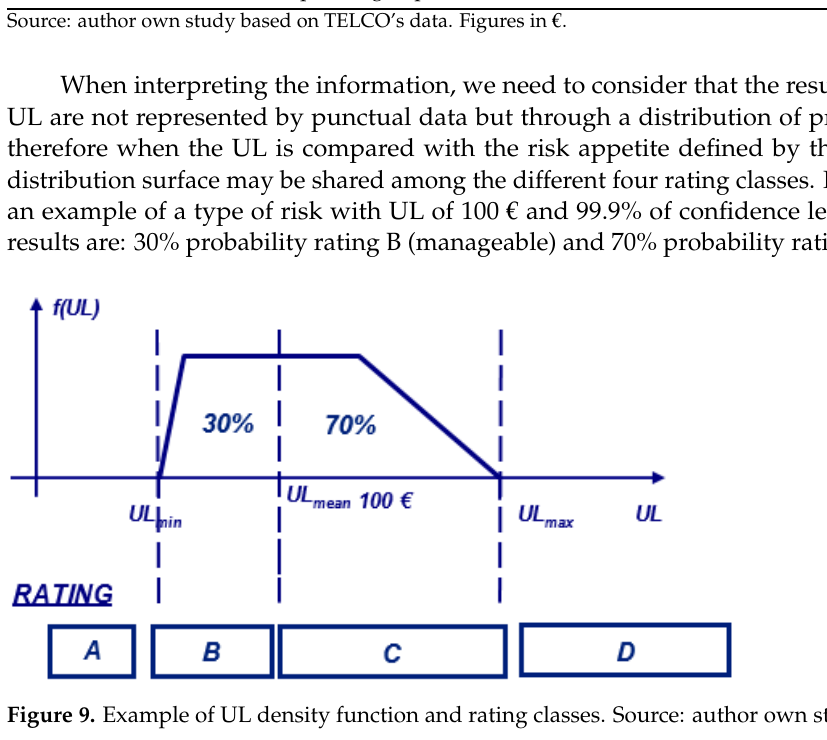
Table 5. Results of Residential organizational unit.